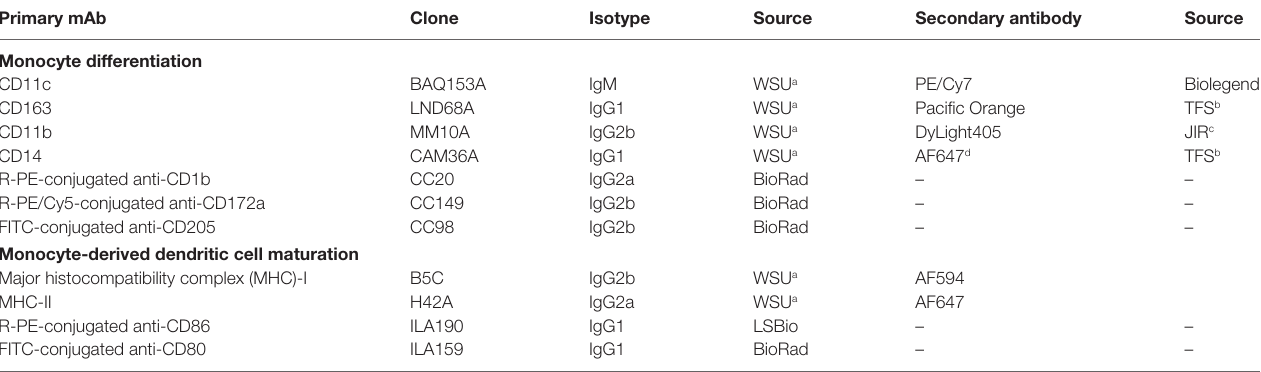
TaBle 1 | anti-bovine monoclonal antibodies used for peripheral blood mononuclear cell immunophenotyping and coculture experiments. Primary mab clone isotype source secondary antibody